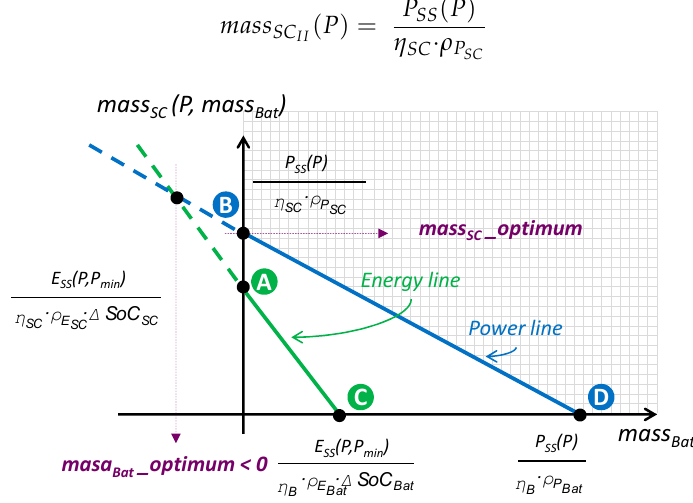
Figure 4. Equations system graphic solution in the second quadrant.